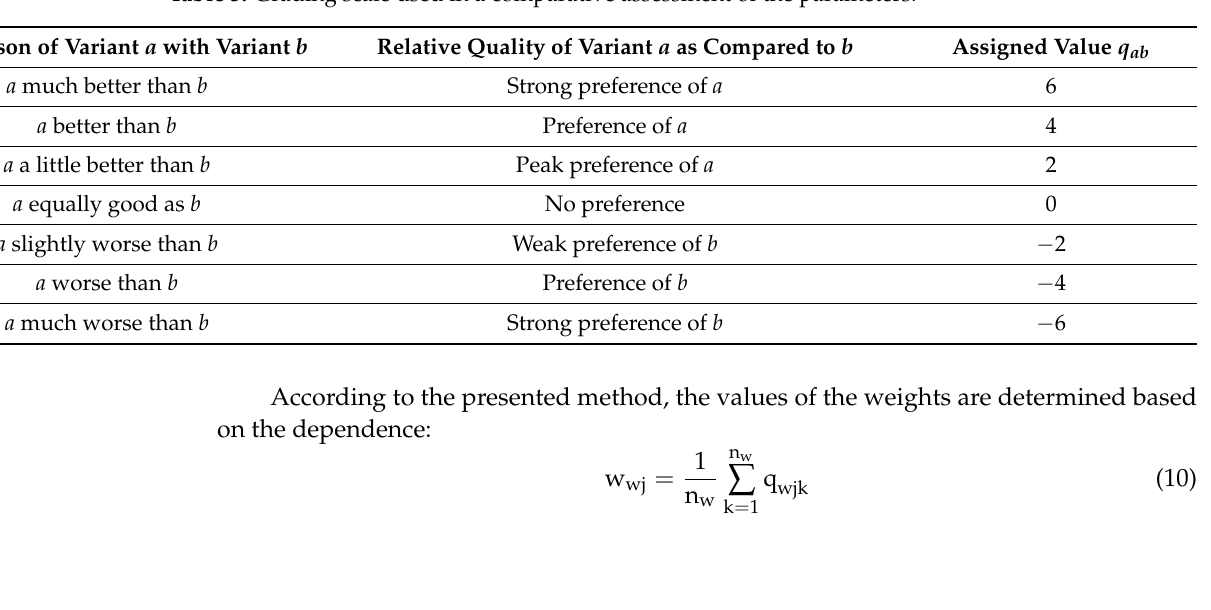
Table 3. Grading scale used in a comparative assessment of the